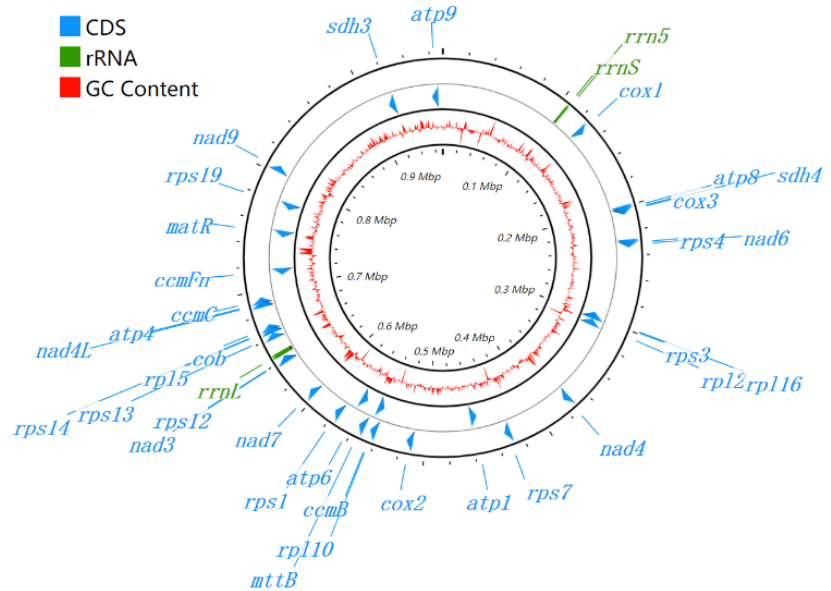
Figure 2. Mitochondrial gene map of C. gigantocarpa